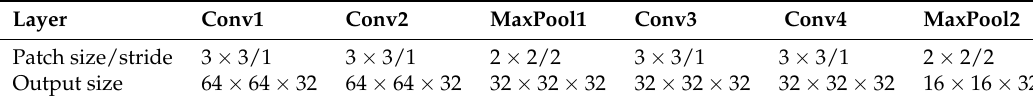
Figure 2. The proposed CRF-XmasNet architecture integrating CRFs [31] into the baseline XmasNet [33] as an end-to-end approach. This hybrid network, allowing for joint training via backpropagation, analyzes three non-contrast-enhanced mpMRI sequences (namely, T2w, T1w and ADC) and yields a prediction probability for each CS PCa case.More specifically, the whole architecture can be divided into three components: ( i ) downsampling, ( ii ) upsampling, and ( iii ) classification. In order to effectively merge the information from multiple layers into the CRF, three skip connections were added. The legend box shows the symbol notation and color semantics. The digits above the layers outputs represent the depth. Table 1. Downsampling component network parameters.